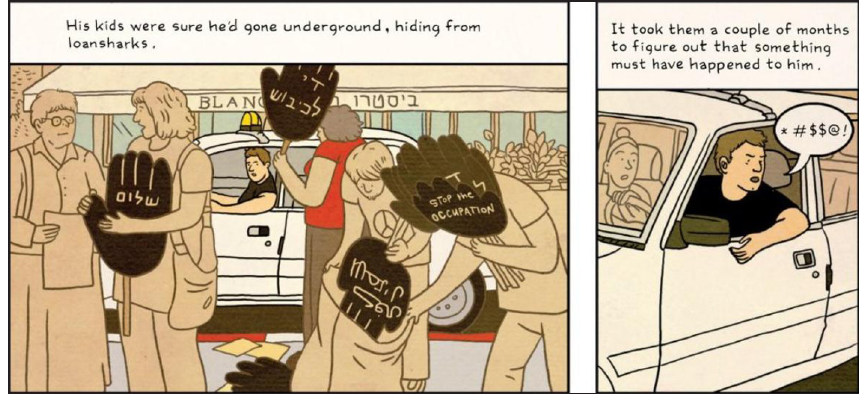
Figure 6: Protestors Violating Social Norms Elicit an Uncivil Reaction in Exit Wounds by Rutu Modan, 2007: 64. © 2007 Drawn & Quarterly – Rutu